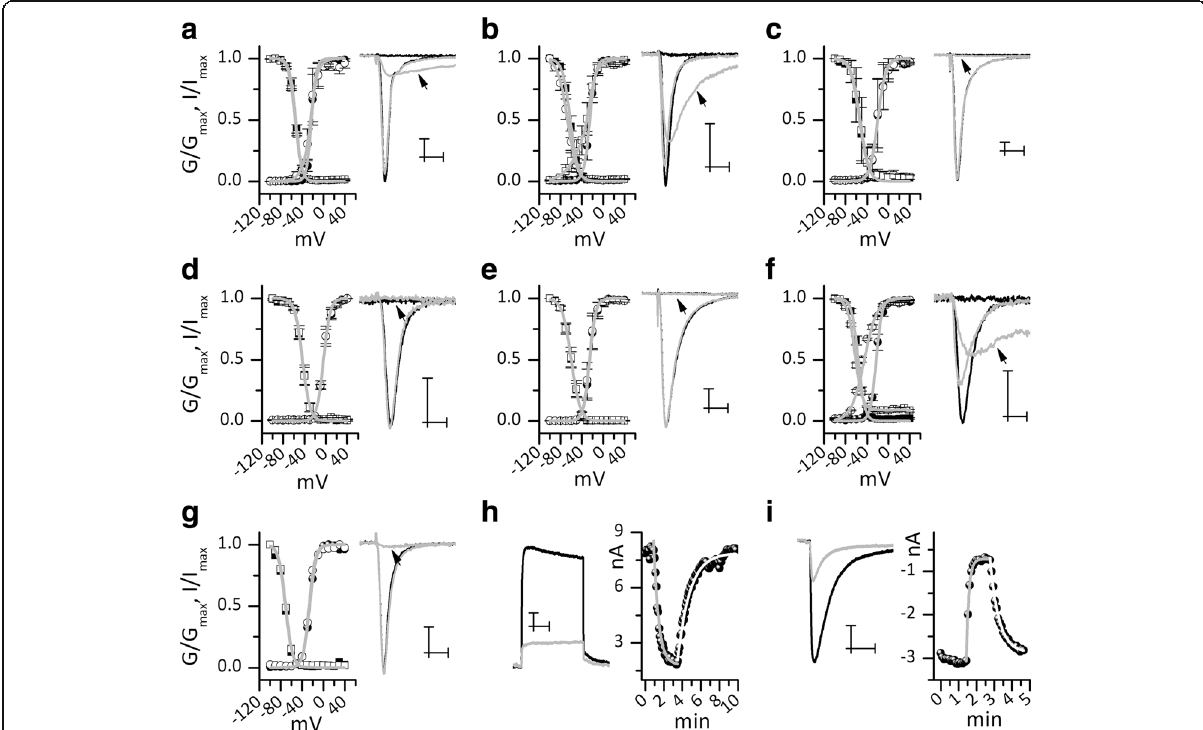
Fig. 4 Electrophysiological characterization of soluble venom. The effect of soluble Centruroides hirsutipalpus venom on sodium and potassium ion channels. From panels A to G: sodium currents of hNav 1.1 to 1.7 channels, respectively. On the right side of each panel are represented the current traces elicited with stimulus at − 10 mv (maximal current) and at − 50 mv (sub-threshold stimulus). Black lines are for control and grey lines are for venom application. In ( a ) hNav 1.1, ( b ) hNav 1.2 and ( f ) hNav 1.6, venom produced current at − 50 mV (arrow) and reduction of the maximal current. The ( c ) hNav 1.3, ( d ) hNav 1.4, ( e ) hNav 1.5 and ( g ) hNav 1.7 were insensitive to the venom. In each panel, on the left, are represented the activation (circlet) and the inactivation (squares) curves. Full symbols are for the control and empty symbols are for the venom. Grey line are the best fit from a Boltzmann equation or the sum of two Boltzmann equations. In ( a ), ( b ) and ( f ) venom moves activation curve to more negative potentials. ( h ) Venom produced current reduction on hKv 1.1 channels. The left side shows current in control (black line) and after venom application (grey line). On the right, current values were plotted against time and data were fitted with a first-order exponential equation. Grey line is the best fit of the on-kinetic data and light gray line is the best fit of the off-kinetic data. ( i ) Venom produced current reduction on hERG1 channels. The left side shows current in control (black line) and after venom application (grey line). On the right, current values were plotted against time and data were fitted with a first-order exponential equation. Grey line is the best fit of the on-kinetic data and light gray line is the best fit of the off-kinetic data. Scaler is 1 ms and 1 nA in panels ( a ), ( b ), ( c ), ( e ), ( g ); 1 ms and 0.5 nA in panels ( d ), ( f ); 50 ms and 1 nA in panels ( h ) and ( i )